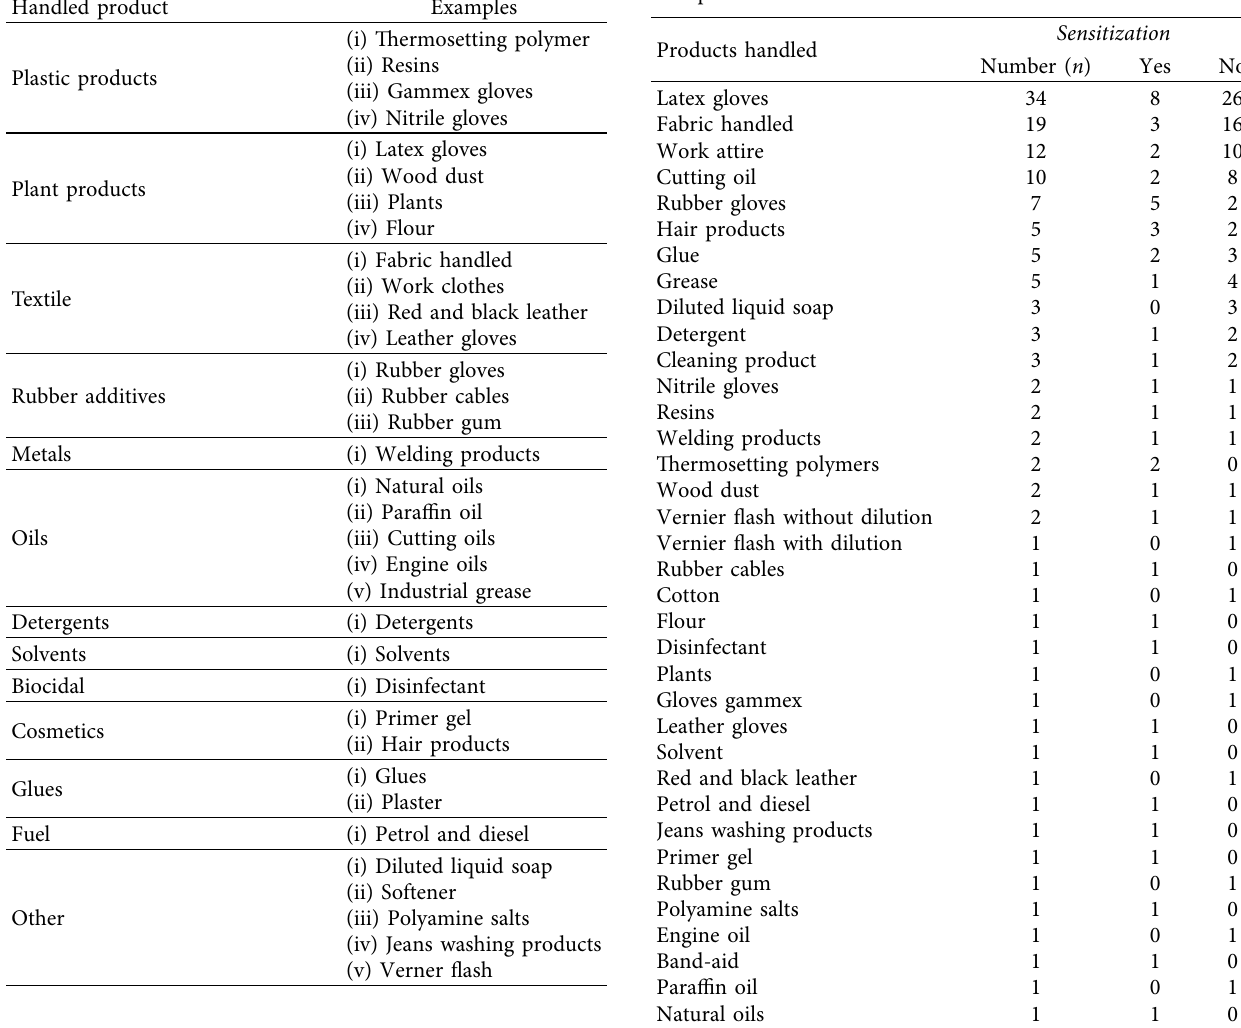
Table 3: Distribution of handled products. Table 4: Results of patch tests with products handled in the